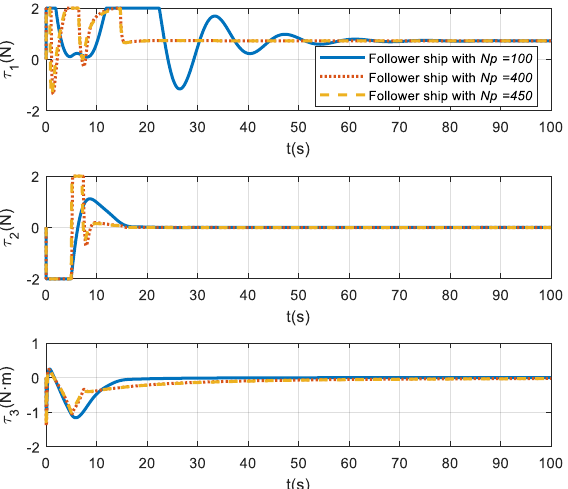
Figure 7. The responses of control inputs with disparate prediction horizon.